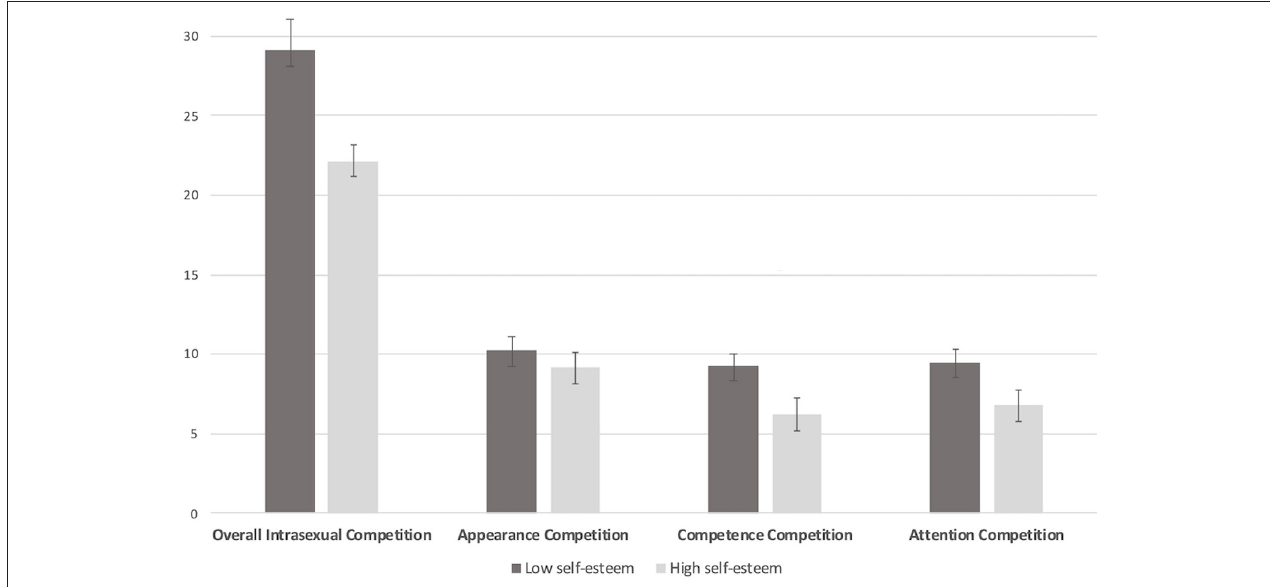
FIGURE 1 | Model-based estimates of the relationship between intrasexual competition (overall score and subscales of the scale for intrasexual competition) and self-esteem in postmenopausal women.